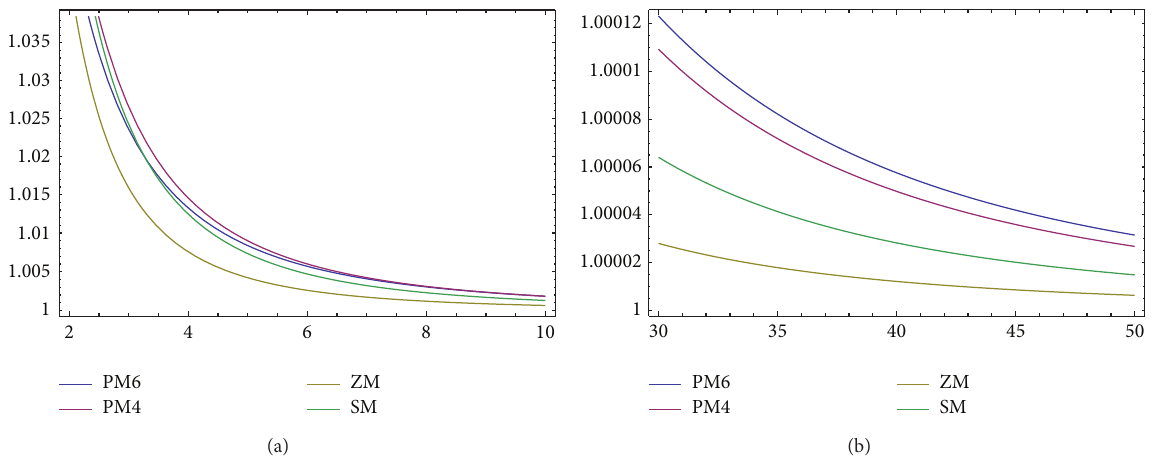
Figure 1: The log plot of the efficiency indices for different methods (a) when 𝑁 = 4,...,10 and (b) when 𝑁 = 30,...,50 .